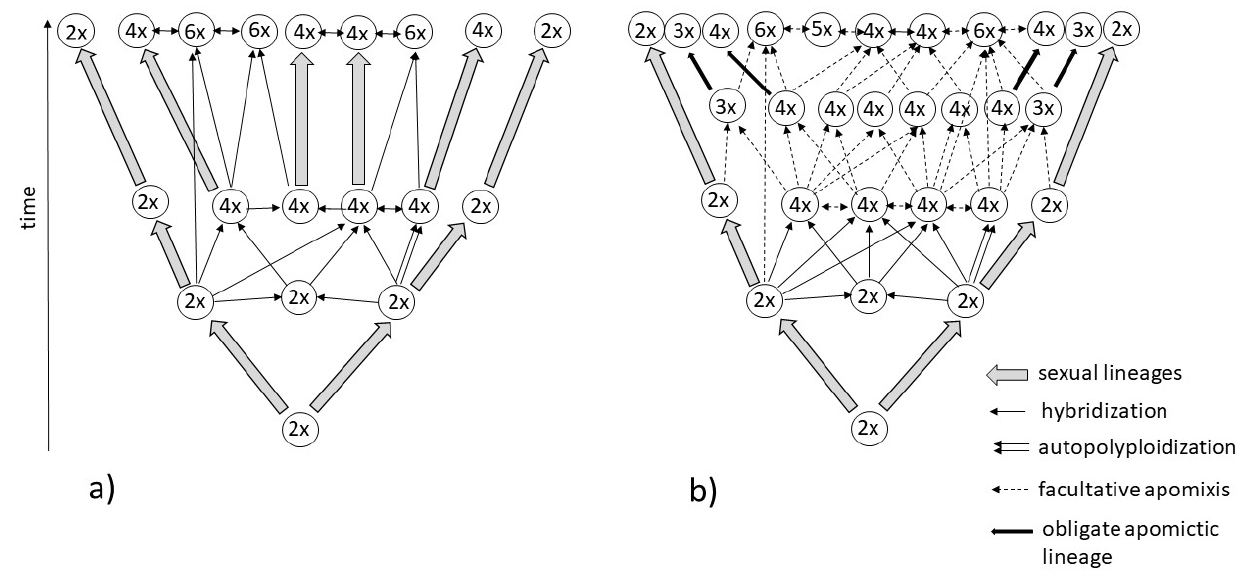
Figure 1. Schemes of polyploid complexes arising from two sexual progenitor species. Inter-lineage crossings between the same ploidy levels are assumed to be more successful than between ploidy levels. ( a ) Sexual polyploid complex, forming stable hybrid lineages that can be delimited as species. ( b ) Apomictic polyploid complex: sexual progenitors can be delimited as species, facultative apomicts form clusters of many hybrid biotypes; obligate apomicts could be delimited as agamospecies.